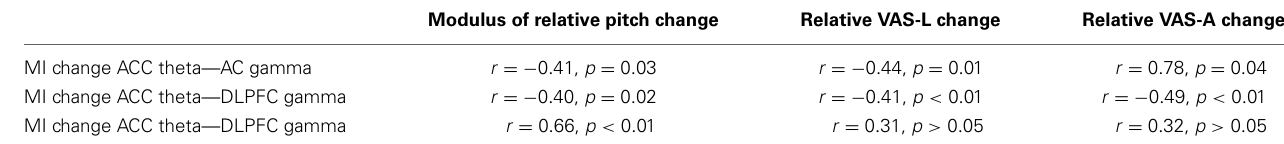
Table 1 | Correlations between changes of MI and changes of the modulus of the tinnitus pitch change ratio, VAS-L/VAS-A. Modulus of relative pitch change Relative VAS-L change Relative VAS-A